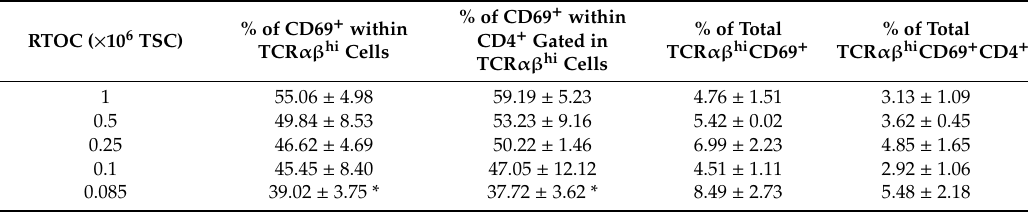
Table 3. Proportions of positive selected thymocytes.